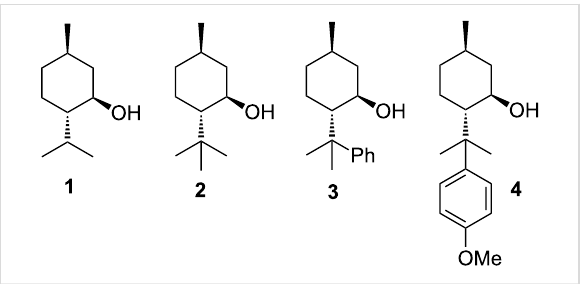
Figure 1: Menthol auxiliaries 1 – 4 used in the following anodic cou- pling